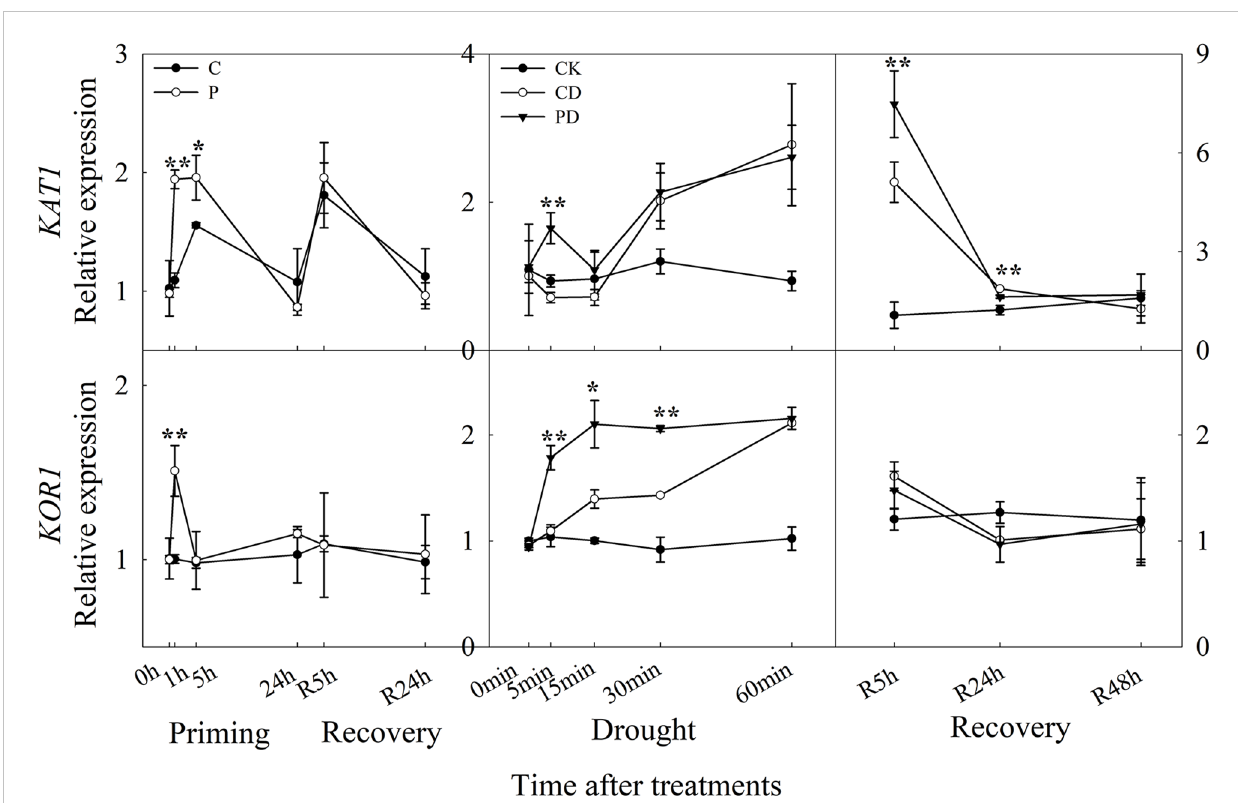
FIGURE 7 Dynamic responses of genes encoding K + inward and outward channels in leaf epidermis of wheat during “ drought priming-recovery-drought stress-recovery ” . C, no drought priming; P, priming; CK, no drought priming + no drought stress; PD, priming + drought stress; CD, no priming + drought stress. *p < 0.05; **p <